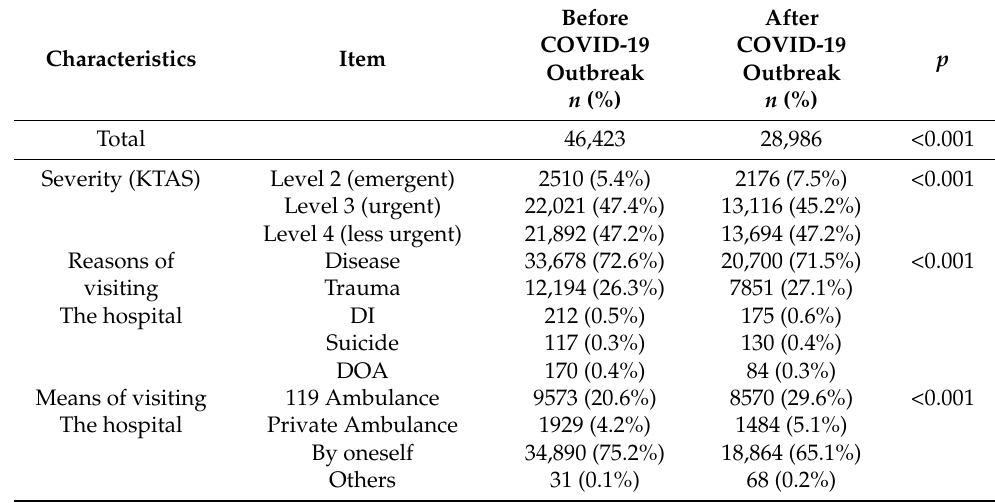
Table 2. Clinical characteristics of emergency room patients before and after the COVID-19 outbreak.